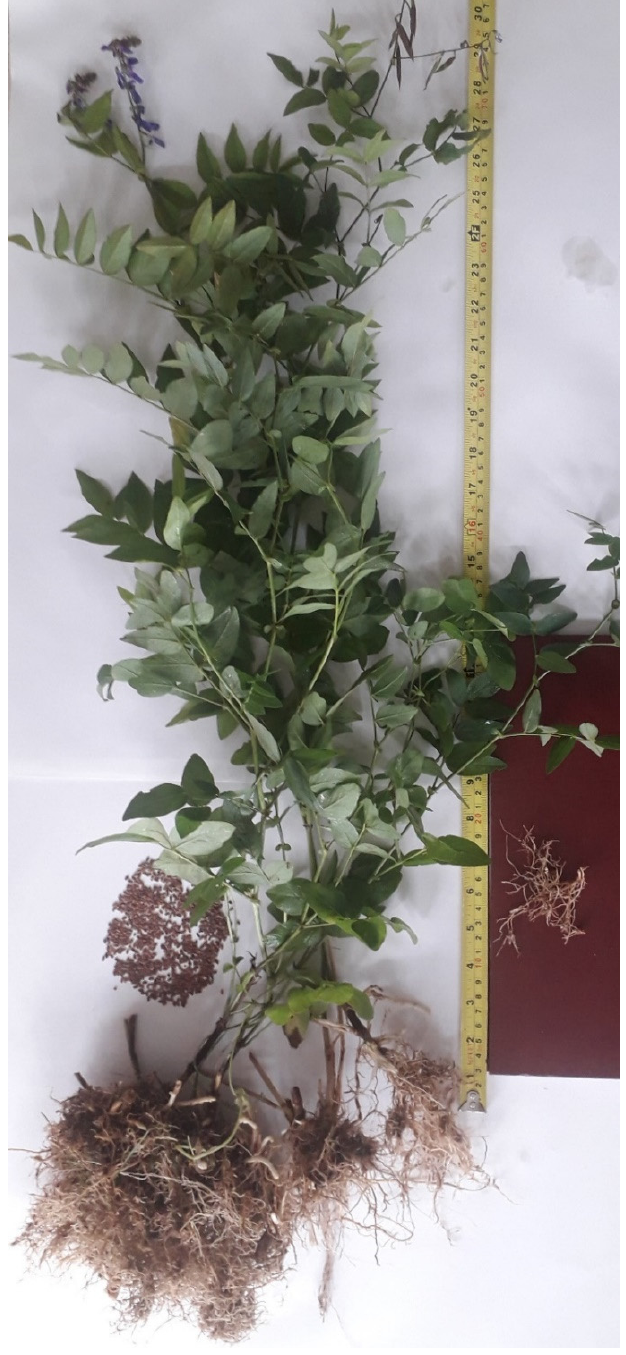
Figure 2. Fodder galega before the third cutting ( Ż arczy ń ski 2021).